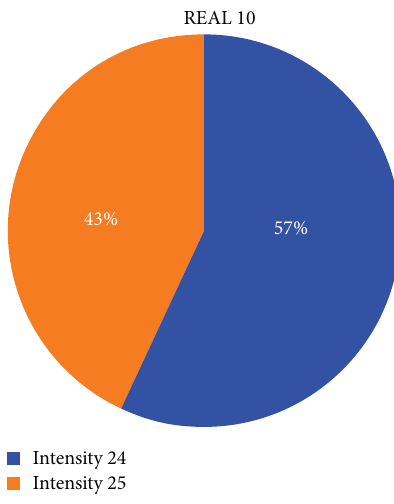
F IGURE 15: REAL 10 result distribution with local search mechanism.